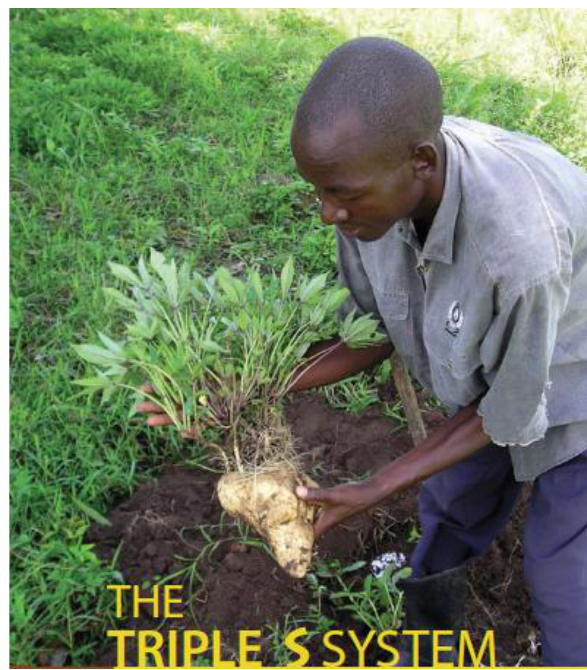
Figure 13: Climate-smart Triple S system (source: Munyua, 2013)